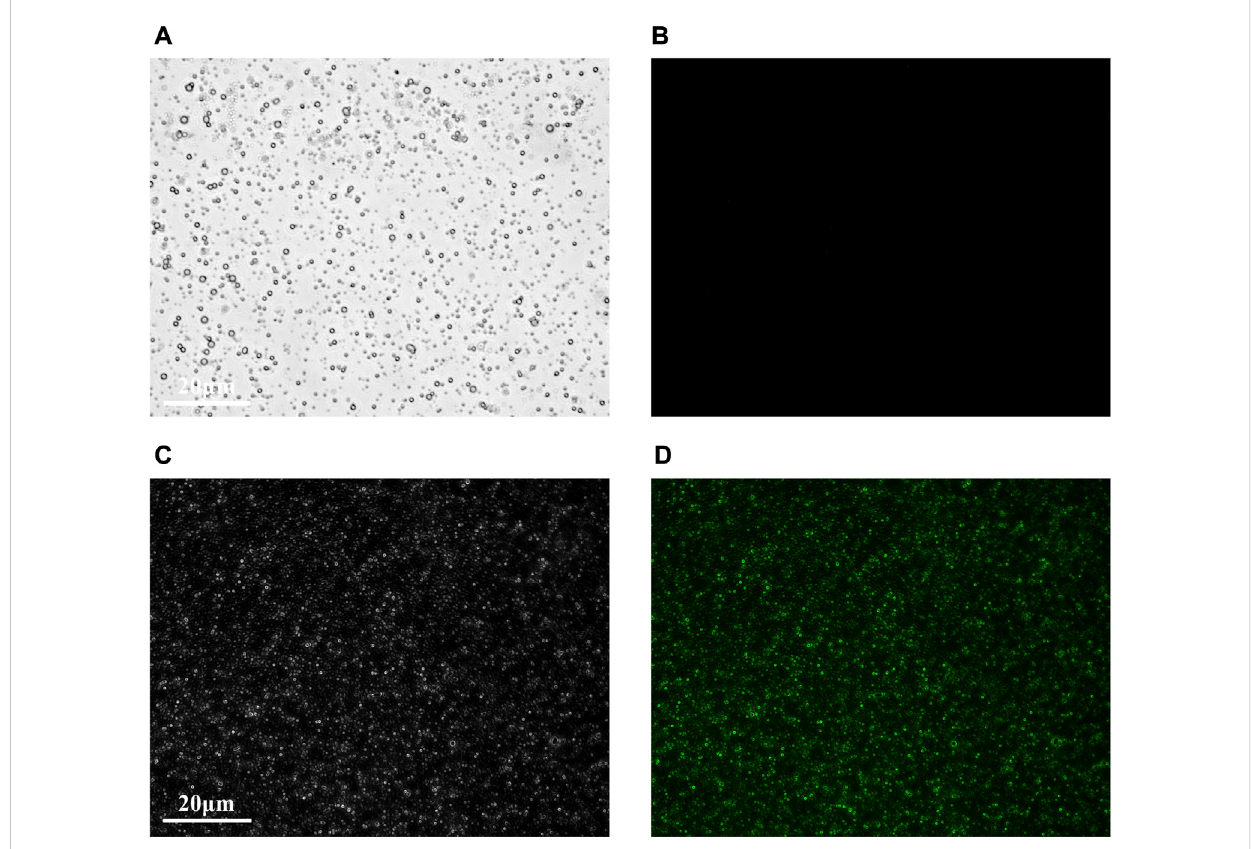
FIGURE 1 Fluorescence microscopic images of control microbubbles (A,B) and targeted microbubbles (C,D) . (A,C) were bright fi eld images and (B,D) were FAM fl uorescence images. Scale bar = 20 μ m.